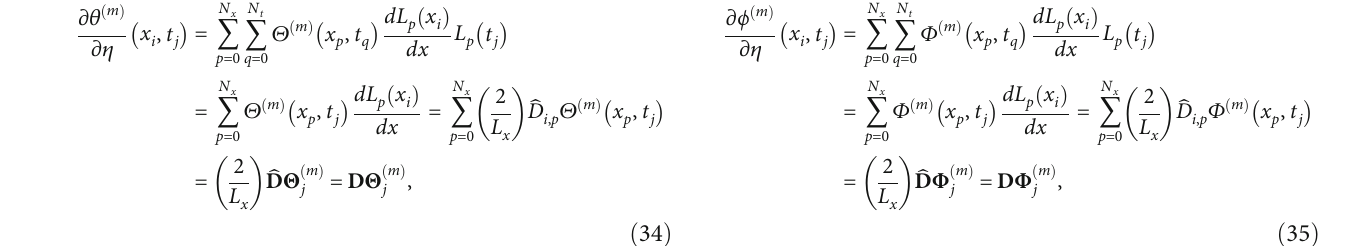
λ = 0 : 1, N = 0 : 5, n = 0 : 5, f b when